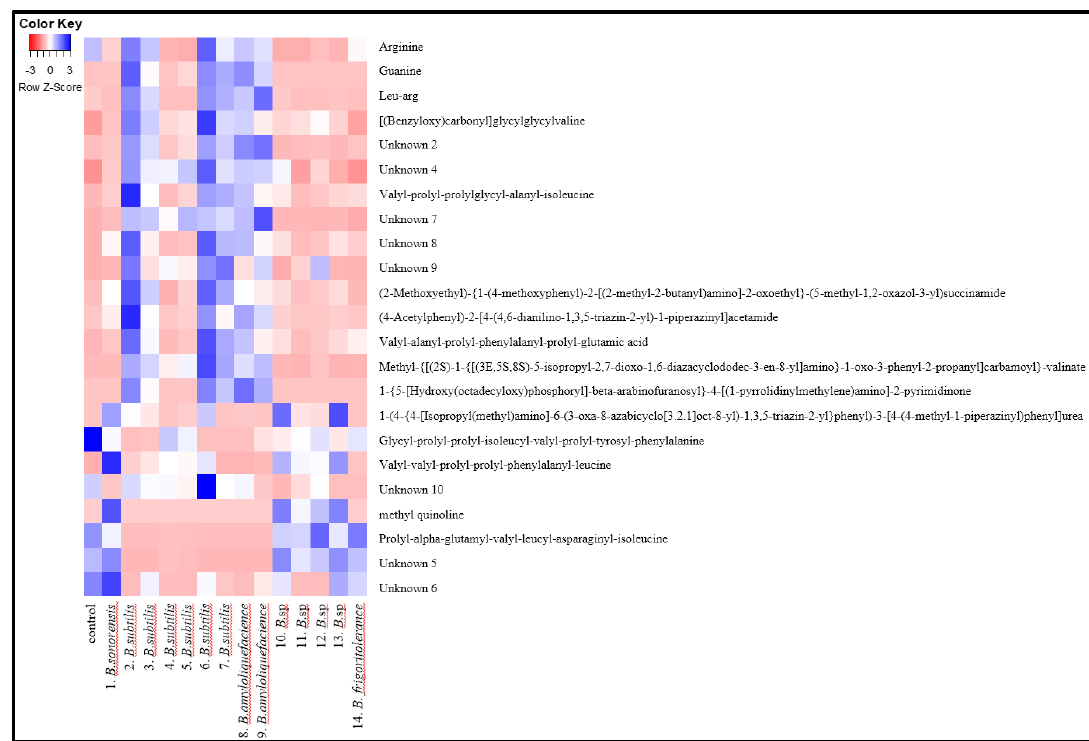
Figure 4. Heat map of non-volatile compounds of culture.